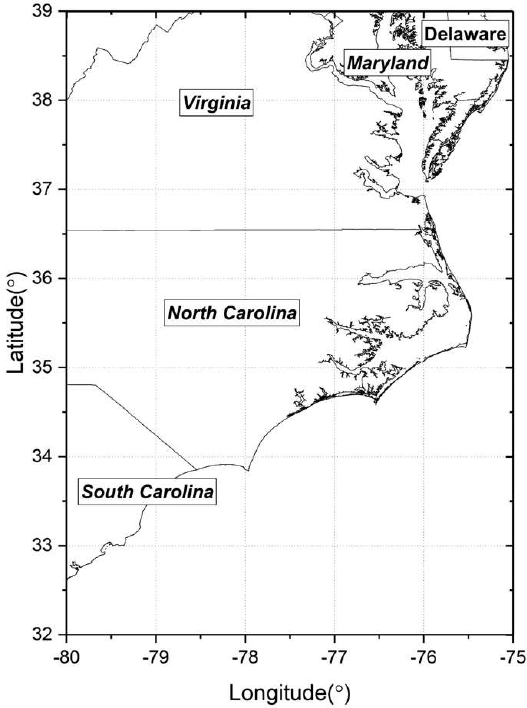
Figure 1. Geographic coverage of study area.